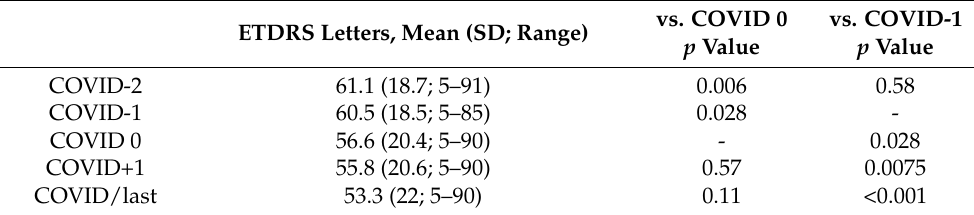
Table 2. BCVA obtained in each visit was compared with BCVA before (COVID-1) and after (COVID 0) lockdown. ETDRS Letters, Mean (SD;